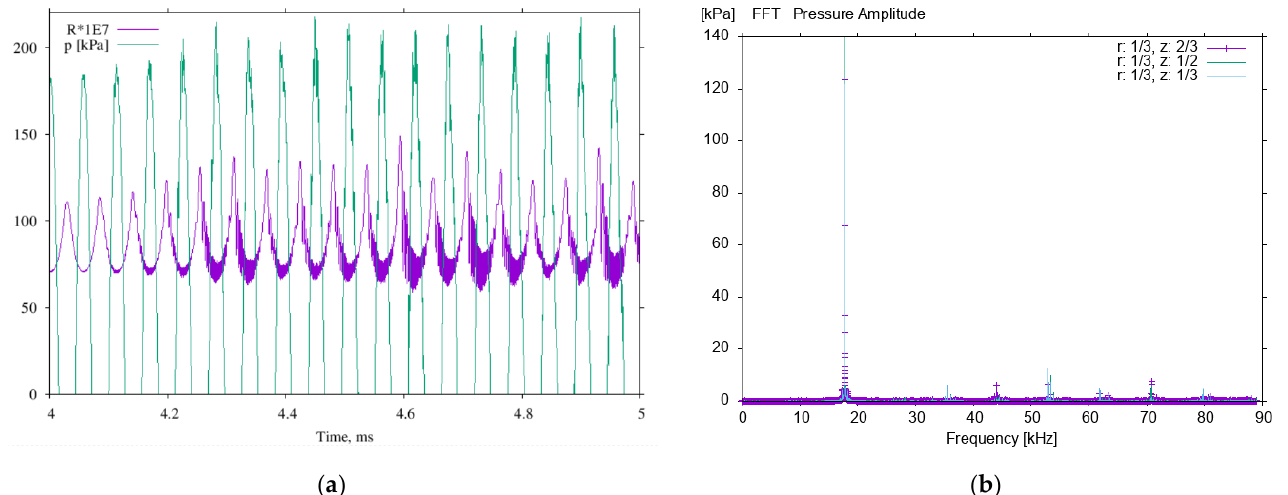
Figure 5. Results analysis: ( a ) zoomed acoustic pressure (positive half-cycles) and bubble radius oscillation around the moment inertial cavitation is reached; ( b ) fast Fourier Transform (FFT) spectrum at the monitoring points from Table 1.